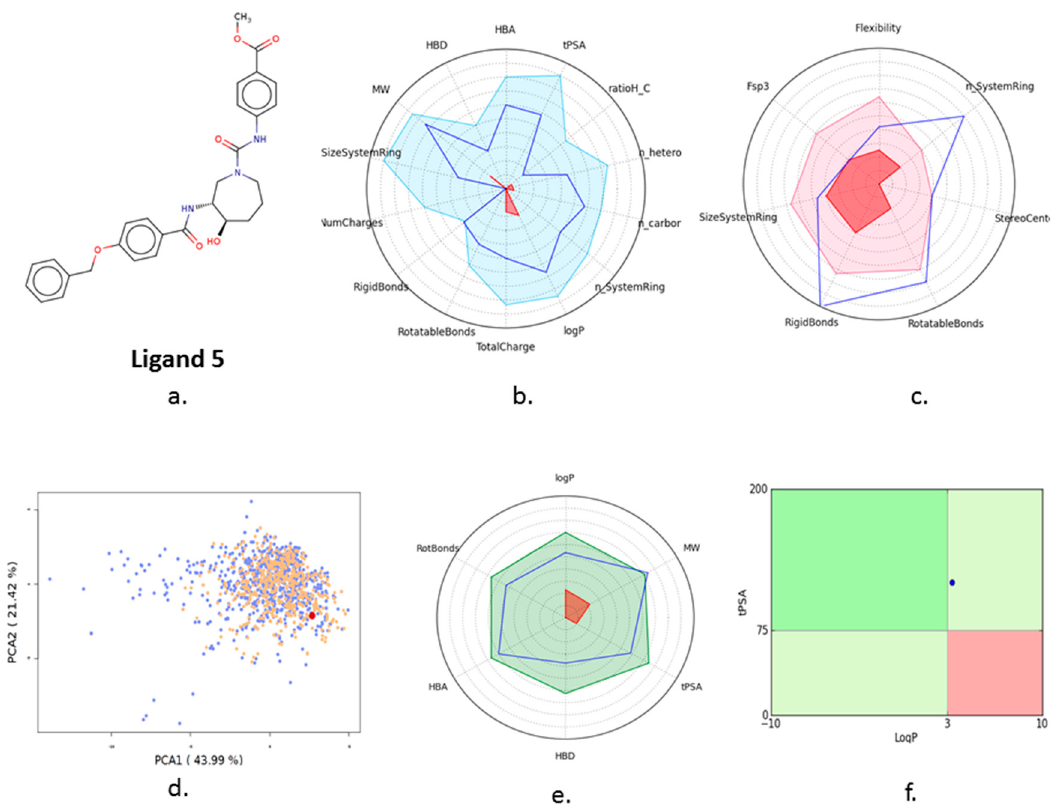
Figure 9. FAF-Drugs4 results for the top five ligand molecules and their respective ADME properties such as: ( a ) 2D structure of each ligand atoms; ( b ) physicochemical filter positioning of all five ligands; ( c ) compound complexity of all five ligands; ( d ) oral property space of all five ligands; ( e ) oral absorption estimation of all five ligands ( f ) Pfizer 3/75 rule positioning of all five ligands.